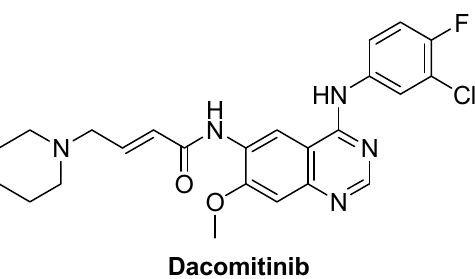
Figure 3. Mechanisms of action of poziotinib and manidipine in ovarian CSCs [115]. Poziotinib and manidipine combination therapy showed synergistic effect in inhibit- ing ovarian CSC by inhibiting HER4 and calcium channel mediated STAT5, AKT and ERK signaling [115].